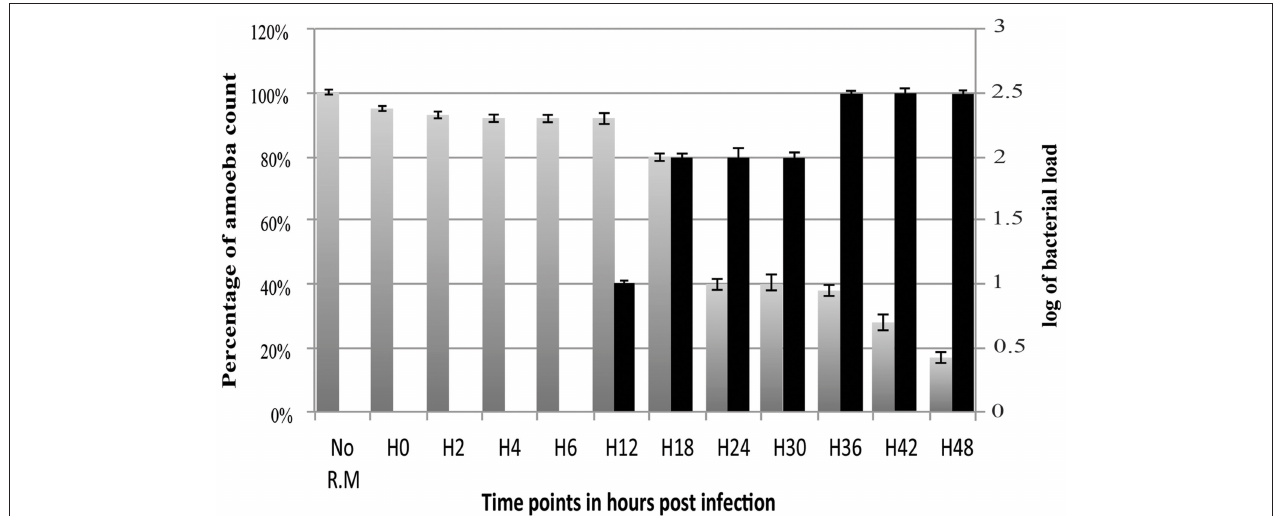
FIGURE 2 | Histogram of R. massiliensis cycle growth in V. vermiformis measured by real-time PCR. X-axis corresponds to the cycle time points in hours (from 0 to 48h). No R.M corresponds to the negative control, which is the non-infected amoeba). Y-axis to the right corresponds to the log of bacterial load (the log values are obtained after conversion of the Cycle threshold (Ct.) values based on standard curves realized with serial 1: 10 dilution starting with 10 7 bacterial particles). Y-axis to the left corresponds to the percentage of amoeba concentrations quantified on kovaslides. This relative quantification by real-time PCR showed the increase in bacterial multiplication coming along with the decrease of the amoeba concentration. No bacterial DNA was detected from H0 till H6. Bacterial titers begin to be detected at H12 p.i, Higher titers are from H18 till H30 with a plateau from H36 until H48